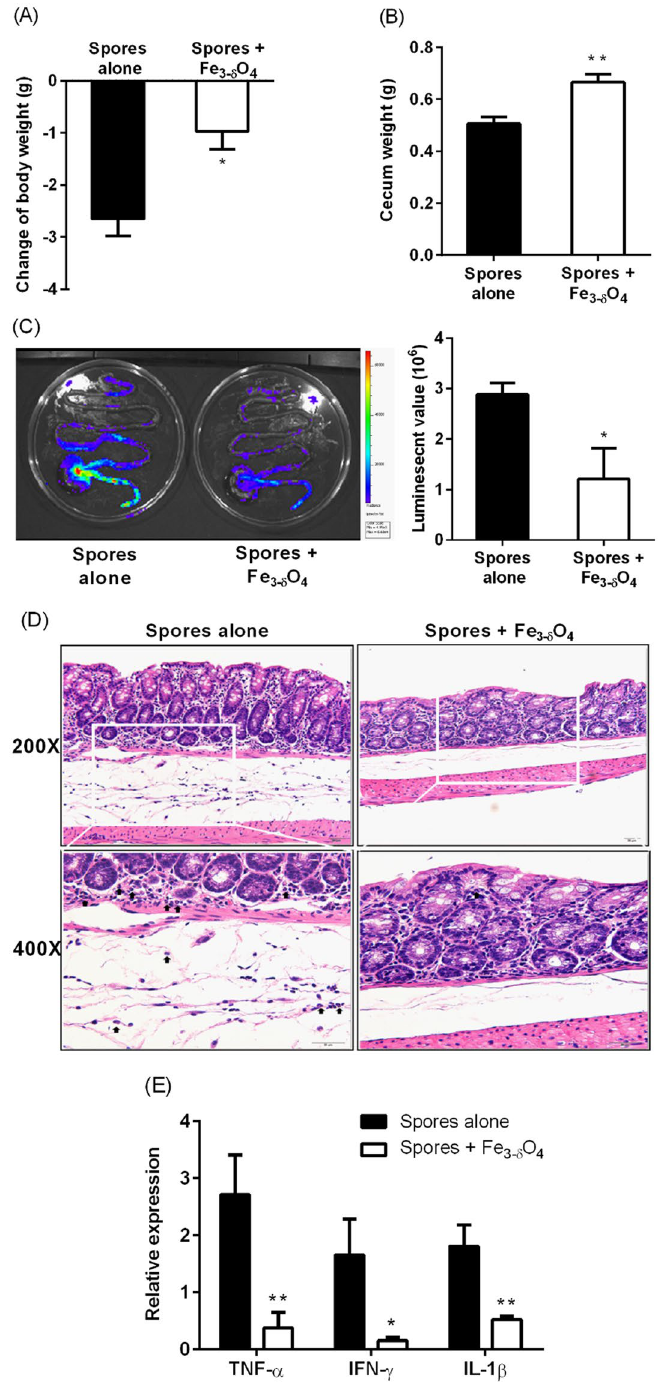
Figure 6. C . difficile infection-induced colitis was attenuated in mice treated with Fe 3- δ O 4 nanoparticles. Purified CCUG 19126 spores were incubated for 20 minutes with Fe 3- δ O 4 nanoparticles, and then the mice were injected with them. Three days later, the mice were killed. ( A ) The mean bodyweight-loss of the Fe 3- δ O 4 nanoparticle-treated mice was significantly lower than that of the spores-alone control mice. ( B ) The mean weight-loss of the cecums of the Fe 3- δ O 4 nanoparticle-treated mice was also significantly lower than that of spores-alone control mice. ( C ) The inflammation of the isolated colon from 11FNL/FVB/NJ transgenic mice with NF- κ B-signal-activated bioluminescence was detected. The left image shows a spores-alone control colon and the right image a Fe 3- δ O 4 -nanoparticle-treated colon. C . difficile infection-induced inflammation was significantly lower in the Fe 3- δ O 4 nanoparticle-treated colon (right panel). ( D ) A histopathological examination of the isolated colon tissue shows prominent infiltration of neutrophils (black arrows in left 400 × panel) in the control group, but attenuated inflammation in the Fe 3- δ O 4 nanoparticle-treated group (right 400 × panel). Neutrophils were morphometrically counted in 10 randomly selected fields in the tissue sections. The